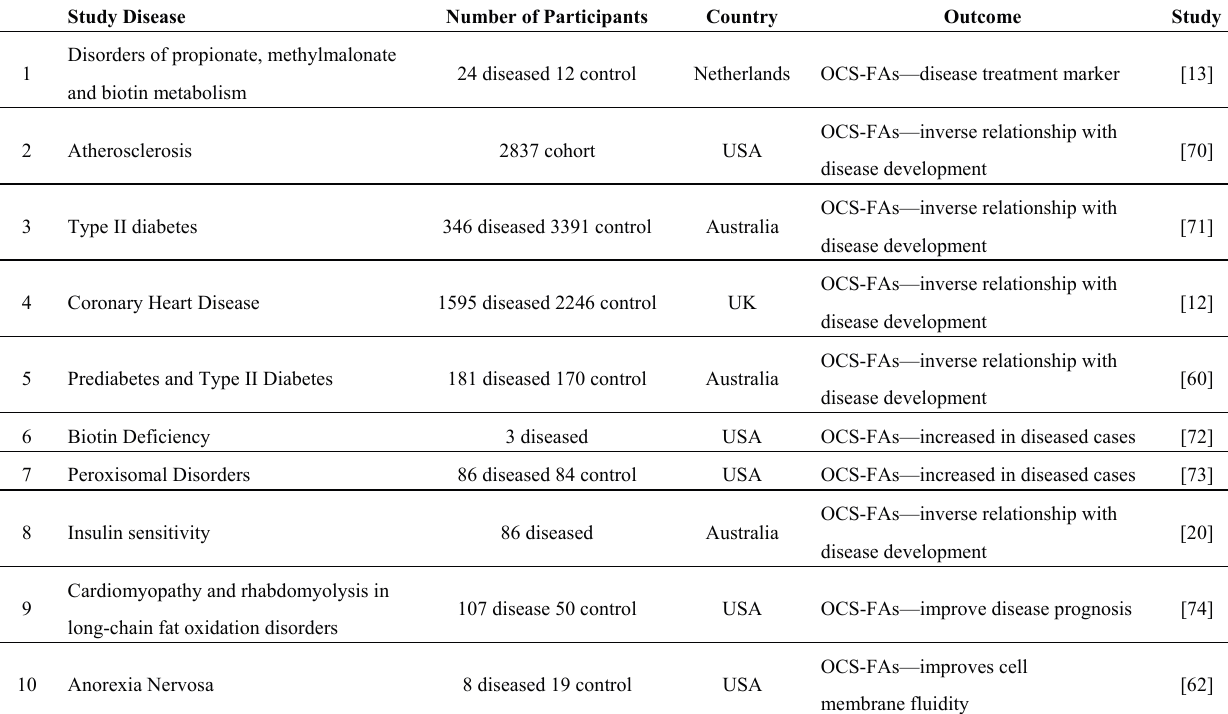
Table 3. Data collated from the literature regarding C15:0 and C17:0 with their association to disease risk, biomarker identification or treatment pathway. This is not a meta-analysis but an illustration that odd chain fatty acids have been associated in several diseases including metabolic and psychological